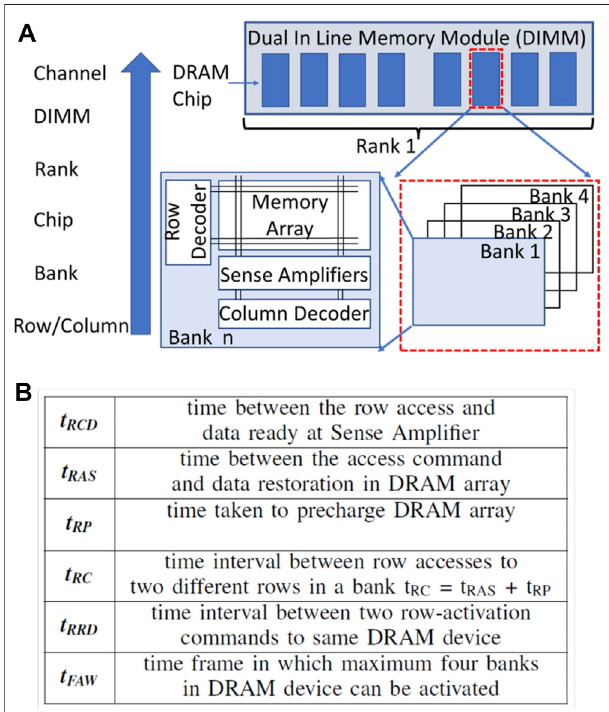
FIGURE 1 | (A) Top-level DRAM architecture and (B) Important Timing Constraints of